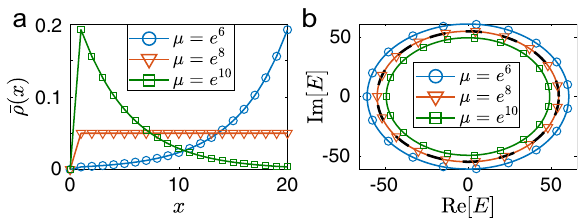
Fig. 2 Average distribution of anomalously accumulating eigenstates and their spectra. a Average distribution of all the anomalously accumulating P L (cid:2) 1 ρ ð x Þ = ð L (cid:2) 1 Þ with ρ x ) = ∣ ψ ∣ 2 , ψ eigenstates (cid:2) ρ ð x Þ ¼ n ( x , n x , n the wave- n ¼ 1 n function value of the n th eigenstate at x , and α = 4, L = 20. The blue, orange, and green cases correspond to reversed scale-free accumulation (SFA), quasi-periodic boundary conditions (PBCs) and SFA. b Spectra for these anomalously accumulating eigenstates, excluding the two isolated eigenstates induced by the strong impurity. The black dashed curve is the true PBC spectrum ( μ = 1), which overlaps with the quasi-PBC orange curve at μ = e 2 α = e 8 . In both panels, the circles, squares, and triangles are numerical data points, and the colored solid curves are approximations from Eqs. (1)